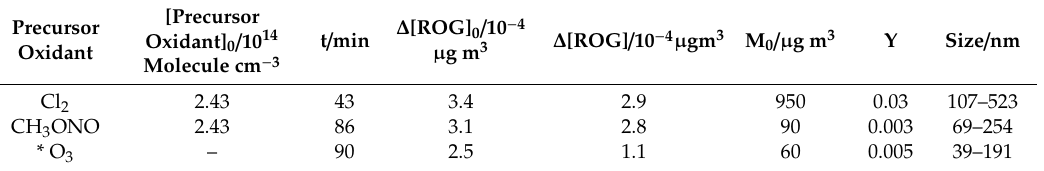
Table 2. Experimental conditions employed for SOA study. Aerosol mass (M 0 ), aerosol yield (Y) and SOA size distribution (diameter) obtained at the end of each studied